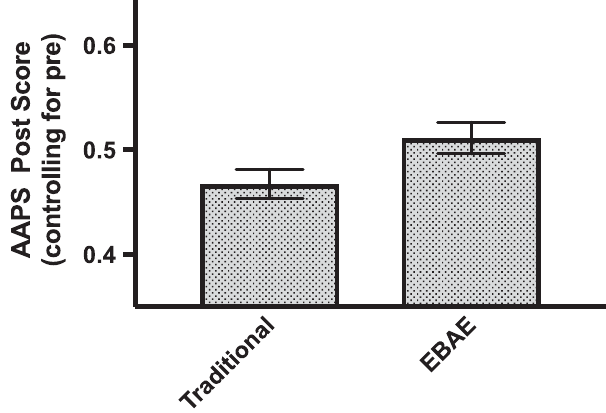
FIG. 2. Controlling for the AAPS survey pretest score in first semester classes for method of instruction, the AAPS post-test scores for traditional classes is significantly lower than that of EBAE classes [ F ð 2 ; 418 Þ ¼ 76 . 498 ; p < 0 . 001 ]. Error bars re- present standard error.